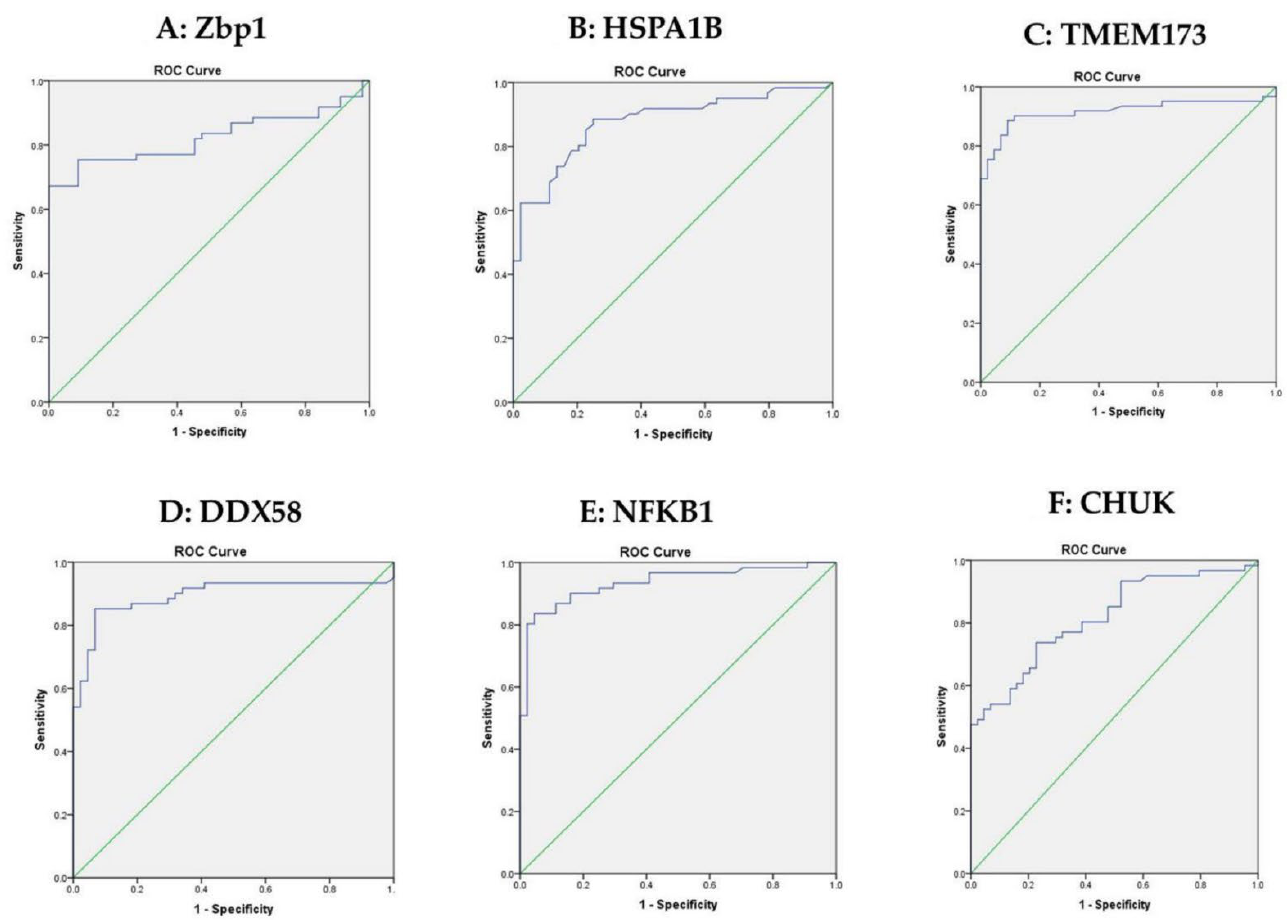
Figure 3. Roc curve analysis for the 6 mRNAs to discriminate between the pre-DM group and T2DM. ( A ): ROC curve analysis for serum Zbp1 used to calculate the best cutoff point to discriminate between pre-DM and T2DM. The best cutoff point for Zbp1 was ≥ 15.590 (sensitivity = 75.4%, specificity = 90.9%). ( B ): ROC curve analysis for serum HSPA1B used to calculate the best cutoff point to discriminate between the pre-DM group and T2DM. The best cutoff point for HSPA1B was ≥ 6.898 (sensitivity = 85.2%, specificity = 77.3%). ( C ): ROC curve analysis for serum TMEM173 used to calculate the best cutoff point to discriminate between the pre-DM group and T2DM. The best cutoff point for TMEM173 was ≥ 12.751 (sensitivity = 90.2%, specificity = 88.6%. ( D ): ROC curve analysis for serum DDX58 used to calculate the best cutoff point to discriminate between the pre-DM group and T2DM. The best cutoff point for DDX58 was ≥ 26.5700 (sensitivity = 85.2%, specificity = 93.2%). ( E ): ROC curve analysis for serum NFKB1 used to calculate the best cutoff point to discriminate between the pre-DM group and T2DM. The best cutoff point for NFKB1 was ≥ 17.350 (sensitivity = 90.2%, specificity = 84.1%) ( F ): ROC curve analysis for serum CHUK used to calculate the best cutoff point to discriminate between the pre-DM group and T2DM. The best cutoff point for CHUK was ≥ 17.740 (sensitivity = 73.8%, specificity = 77.3%). Green line represents diagonal random classifier.